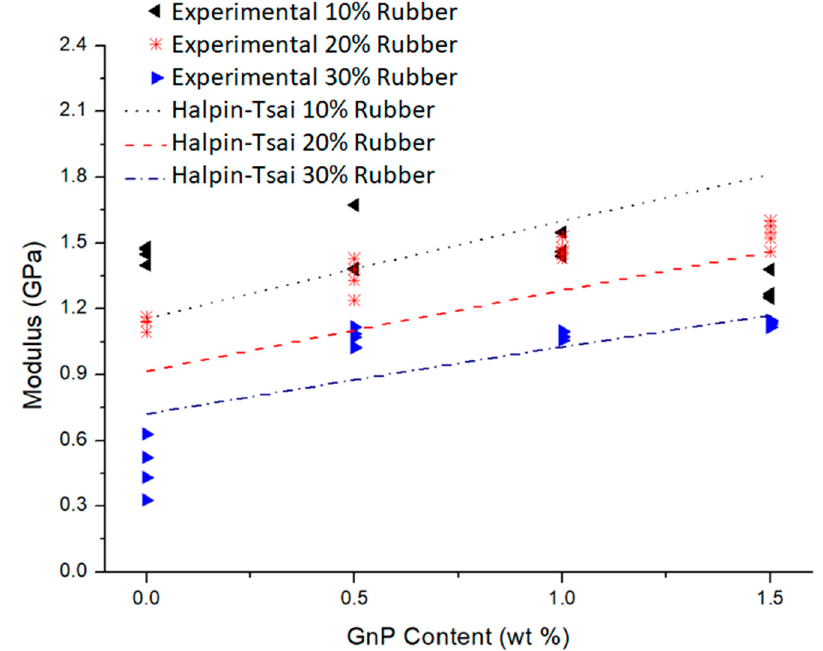
Figure 4. Experimental results and Halpin–Tsai model comparison of elasticity modulus of LRG composites by the increasing content of GnPs.